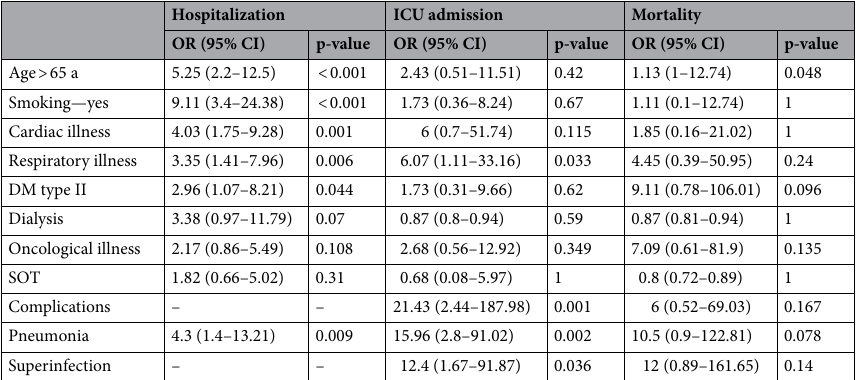
Table 2. Highlights odds-ratios for different variables depending on outcome parameters hospitalization, ICU admission and mortality. SOT, solid-organ transplantation; ICU, intensive care